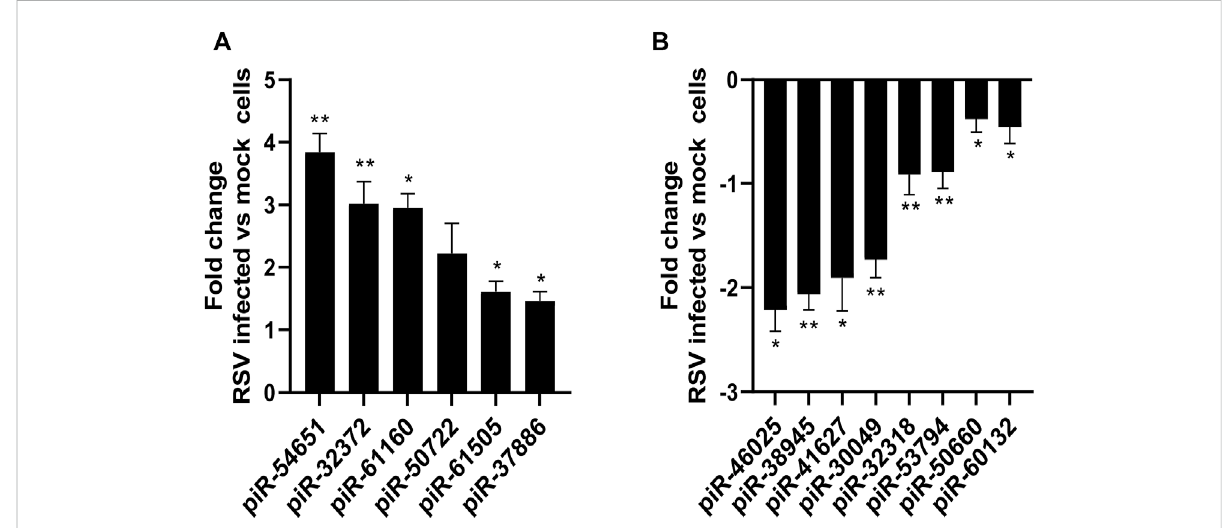
FIGURE 3 Validation of up (A) or down (B) regulated piRNAs expression in SAE cells infected with RSV at 24 h p. i. RNA extracted from SAE mock (uninfected) and RSV infected cells (24 h) was subjected to piRNAs analysis by RT-qPCR. Fold changes in piRNA expression were determined by 2 − ΔΔ CT method and represent mean ± SEM normalized to a small nuclear RNA, U6. * and ** indicates a statistical difference comparing RSV infected versus mock cells (* p value < 0.05; ** p value < 0.01). Data is representative of three independent